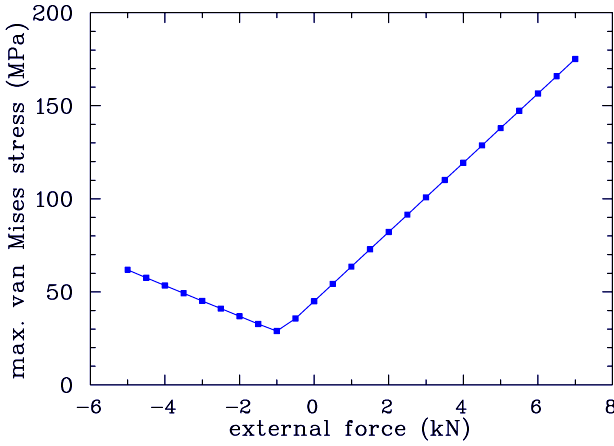
FIG. 40. (Color) Maximum values for the van Mises